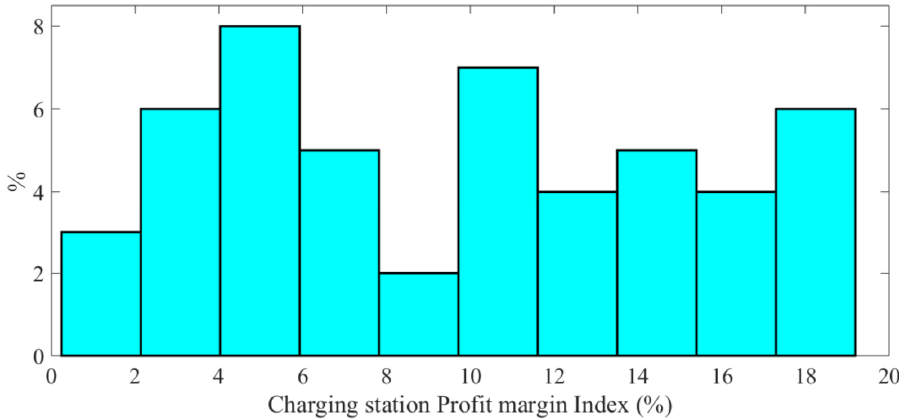
Figure 11. Distribution of the profit margins for the charging stations.